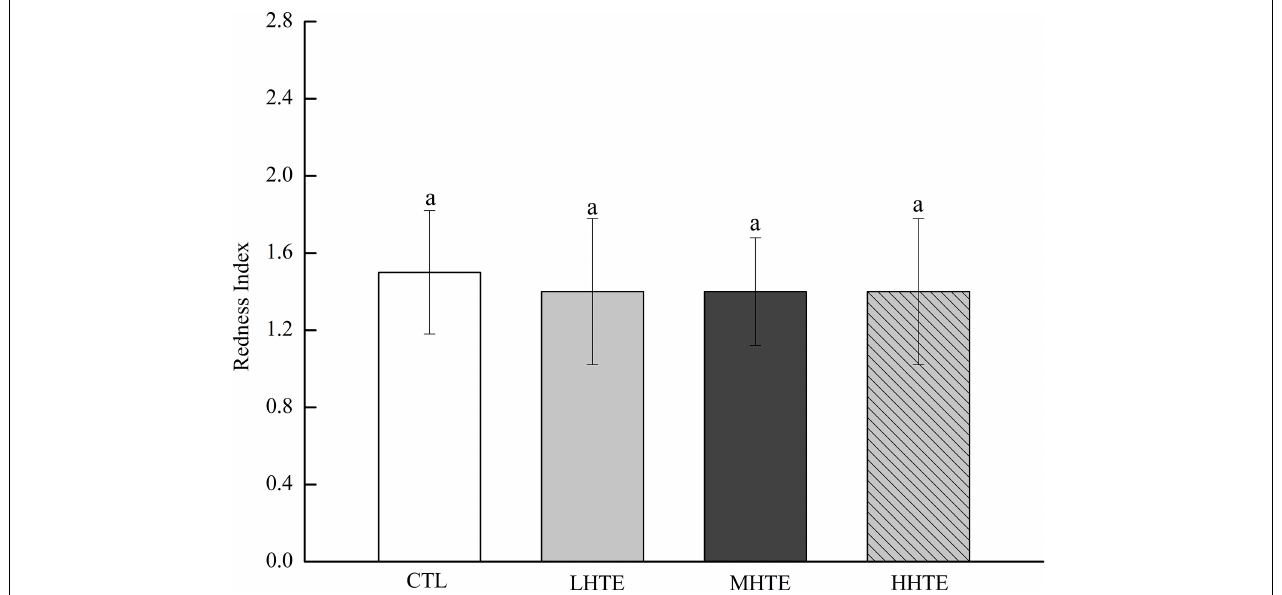
FIGURE 3 | Stomach redness index of fruit flies fed a diet containing hsian-tsao extract (HTE) at low, medium, or high concentrations (LHTE, MHTE, or HHTE) or a non-HTE control diet (CTL) (45 female flies per group, 15 per replicate). Data show mean ± SD. The same lowercase letter indicates no significant differences between groups (LSD test after one-way ANOVA, P >